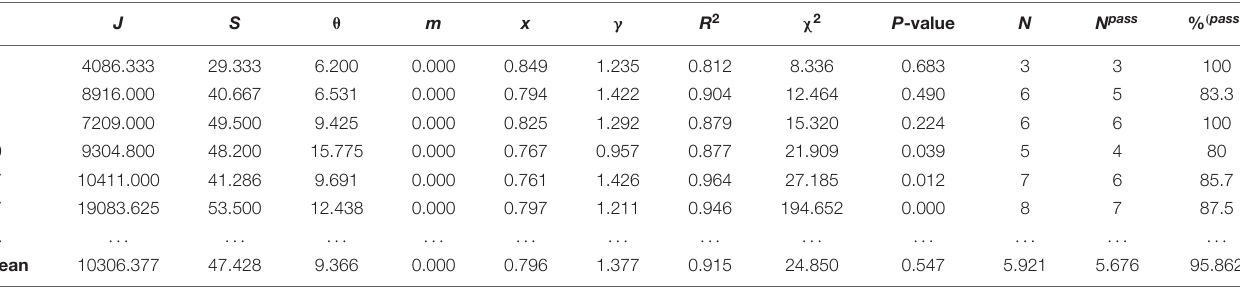
TABLE 2 | The selected test results of fitting Tang and Zhou’s (2013) NNH (niche-neutral hybrid) model to the microbiomes of human digestive tract (DT), excerpted from Supplementary Table 2 in the OSI where the full fitting results from 1,000 times of re-sampling were